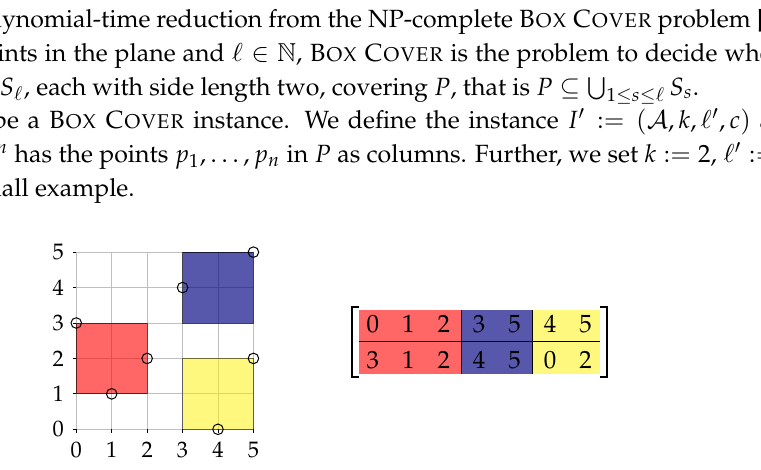
Figure 3. Example of a B OX C OVER instance with seven points ( left ) and the corresponding C O -C LUSTERING ∞ matrix containing the coordinates of the points as columns ( right ). Indicated is a ( 2,3 ) -co-clustering of cost two where the column blocks are colored according to the three squares (of side length two) that cover all